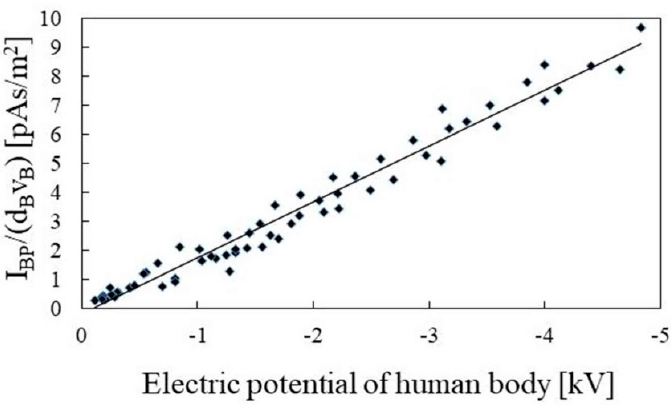
Figure 10. Human potential dependence of the peak value of the electrostatic induction current ( I BP ), trace induced by walking motion divided by the product of walking speed ( v B ), and detection distance ( d B ).